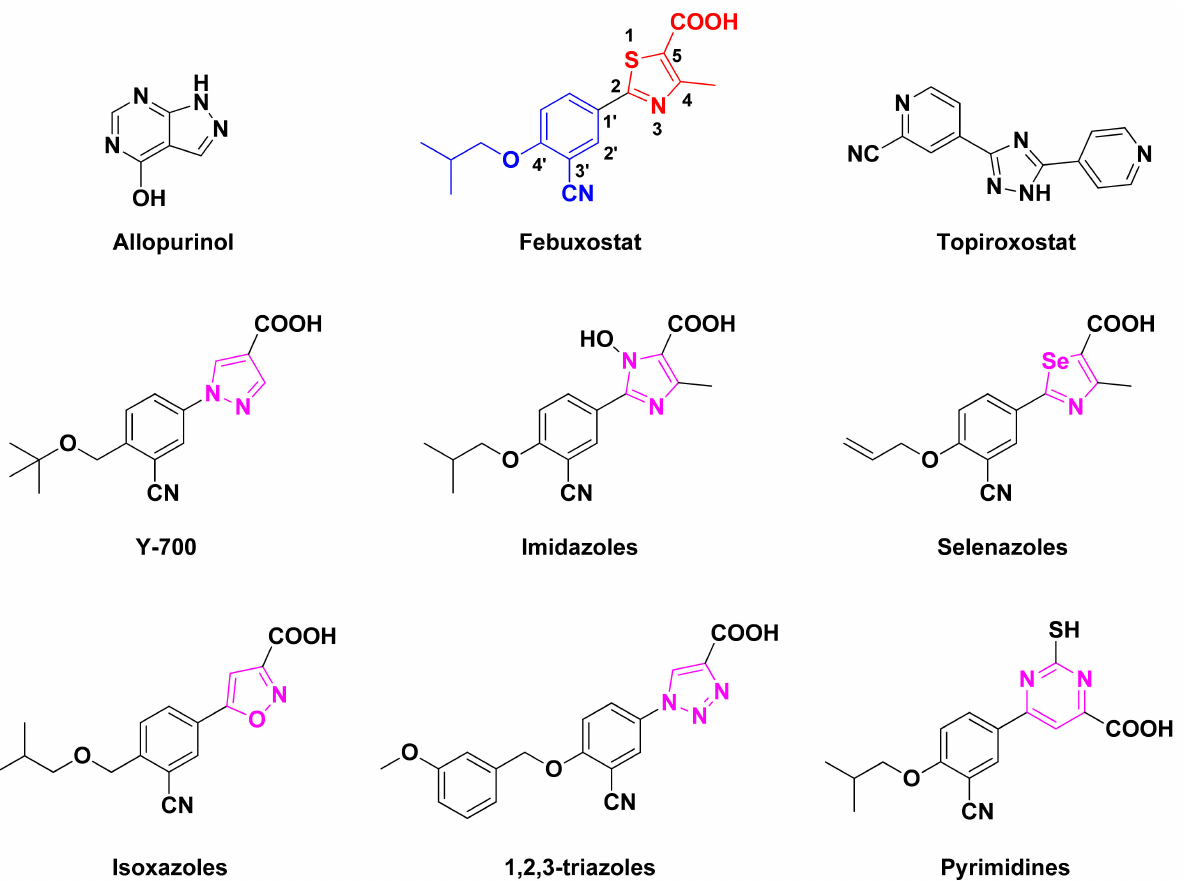
Figure 1. Chemical structures of different XOIs. Febuxostat contains an aromatic moiety (blue) and a nitrogen heterocyclic ring (red). Other febuxostat analogues have different nitrogen-containing heterocyclic rings